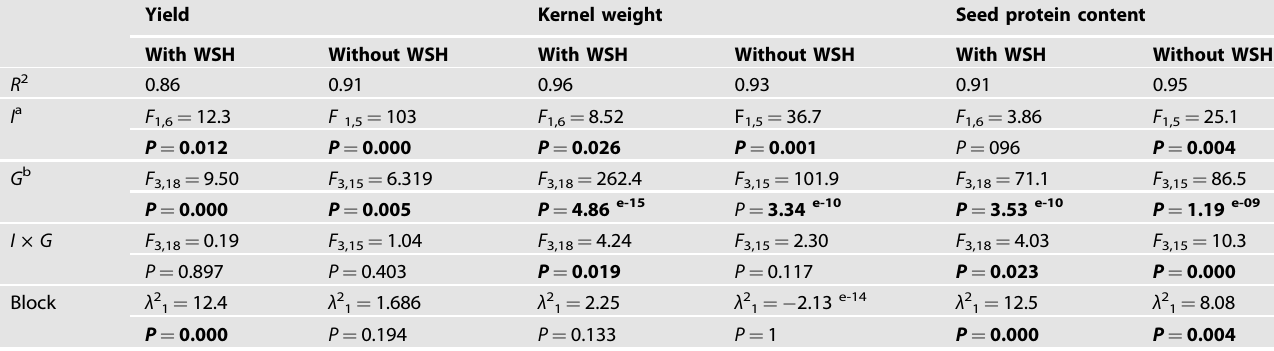
Fig. 1 The irrigation treatment signi fi cantly changes soil and leaf water contents. Effect of the irrigation treatment (irrigated and non- irrigated) on soil water content ( A and B ) and leaf relative water content ( C and D ) for four wheat genotypes grown in two agricultural fi elds with contrasting soil history: without water stress history (without WSH) and with water stress history (with WSH). ANOVA tests are presented in Table 1.